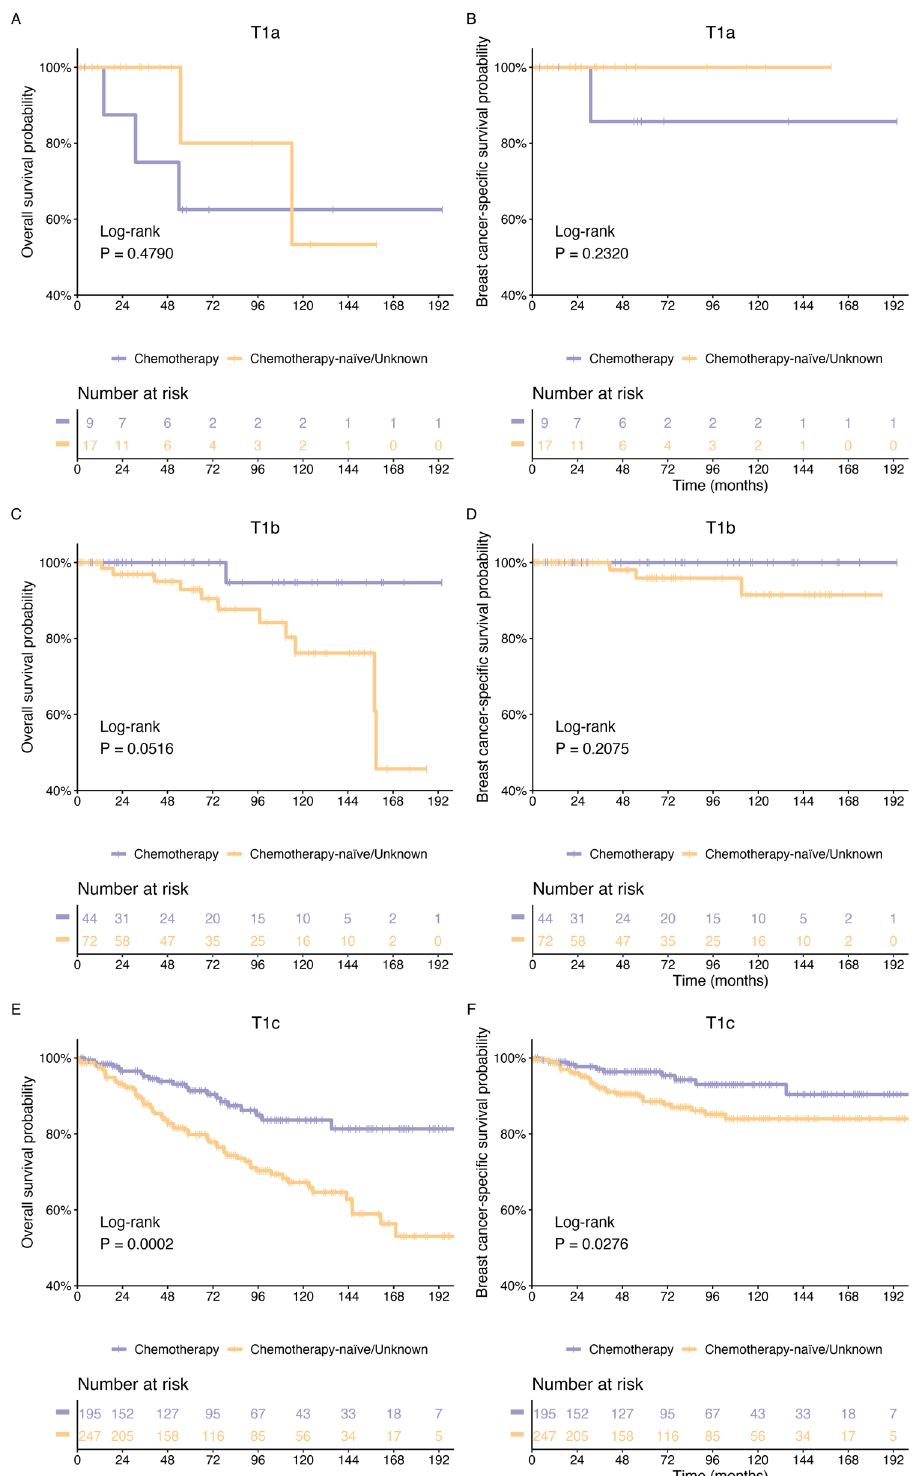
Figure 3. Kaplan–Meier curves comparing survival of patients with MpBC based on chemotherapy and chemotherapy-naïve/unknown ( A , B ) Survival analysis of OS and BCSS in the T1a stage subgroup; ( C , D ) Survival analysis of OS and BCSS in the T1b stage subgroup; ( E , F ) Survival analysis of OS and BCSS in the T1c stage subgroup; P -value was determined by univariate log-rank